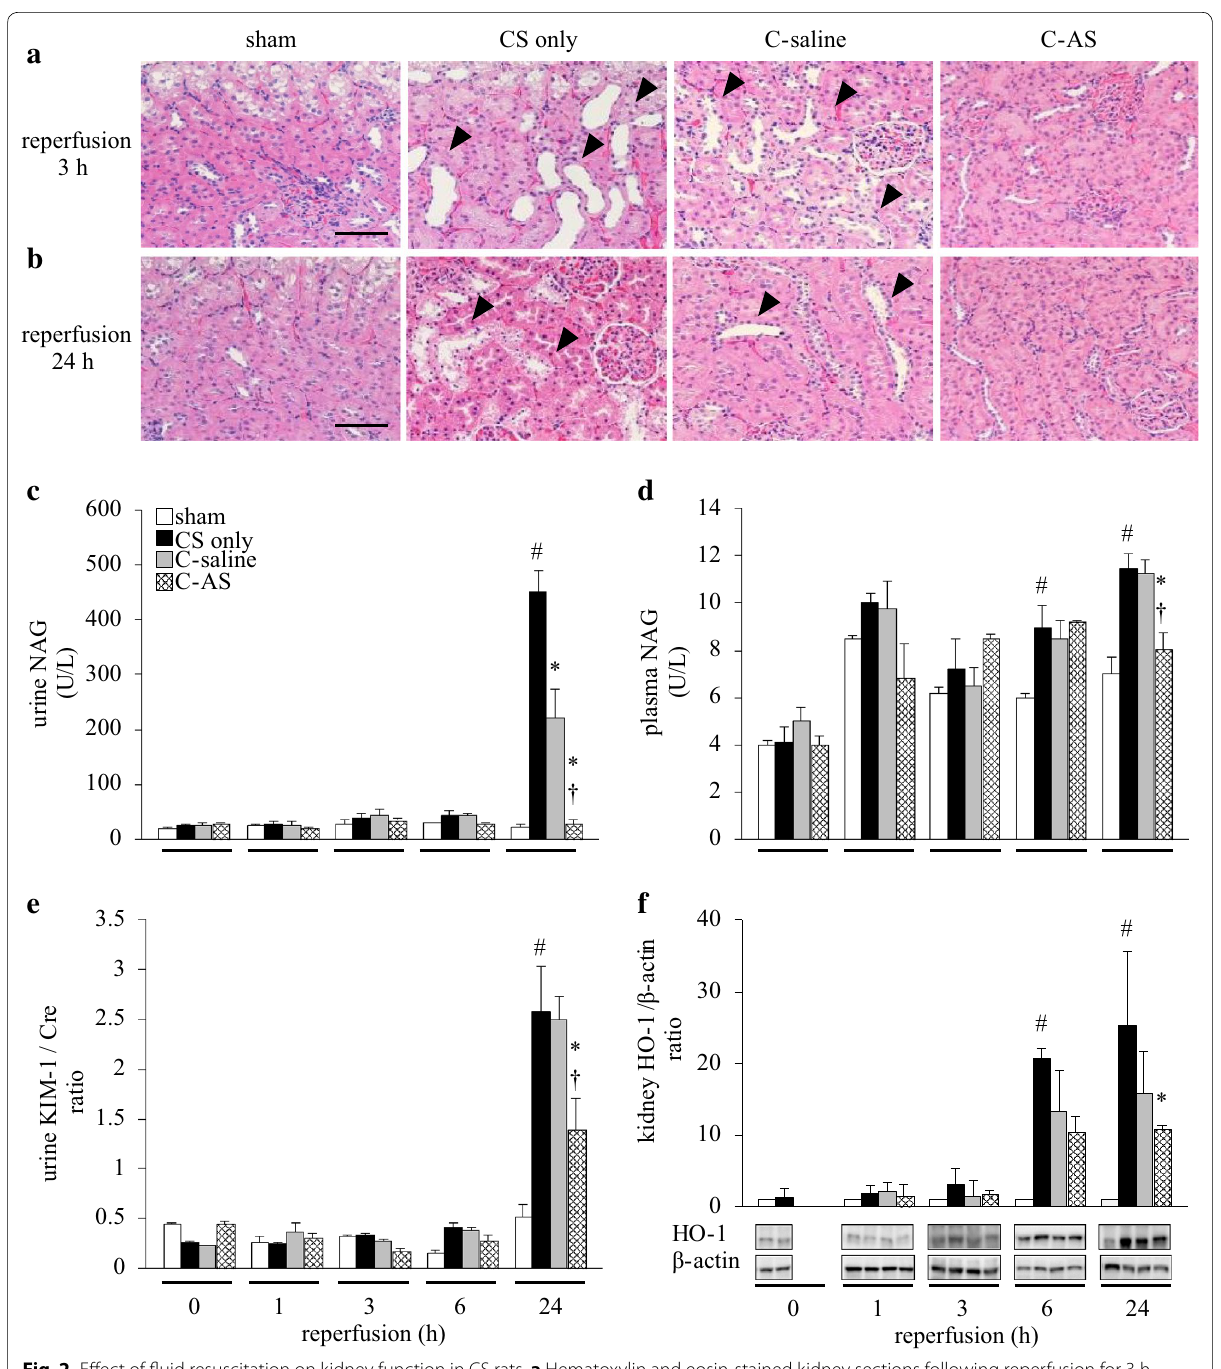
Fig. 2 Effect of fluid resuscitation on kidney function in CS rats. a Hematoxylin and eosin-stained kidney sections following reperfusion for 3 h, b hematoxylin and eosin-stained kidney sections following reperfusion for 24 h, c urine NAG concentration, d plasma NAG concentration, e urine KIM-1/Cre ratio, and f kidney HO-1/β-actin ratio. White bar sham, black bar CS-only, gray bar C-saline, and shaded bar C-AS. Values represent mean SEM ( n 3). # p < 0.05 versus sham group, * p < 0.05 versus CS-only group; and † p < 0.05 versus C-saline group (Tukey’s test). Micrographs ± = are representative of three independent experiments ( 200 magnification; scale bars 100 μm). Black arrowhead dilated kidney tubule. CS crush × syndrome, NAG N -acetyl-β- d -glucosaminidase, KIM-1 kidney injury marker-1, Cre creatinine, HO-1 heme